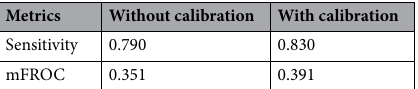
Table 2. The differences in benchmarks with and without the